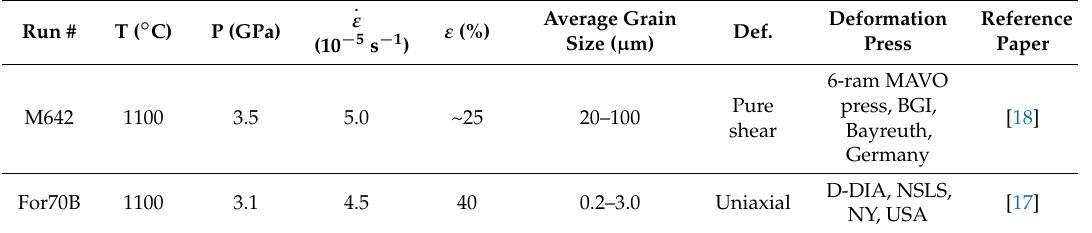
Table 1. Conditions of deformation of the samples characterized in this